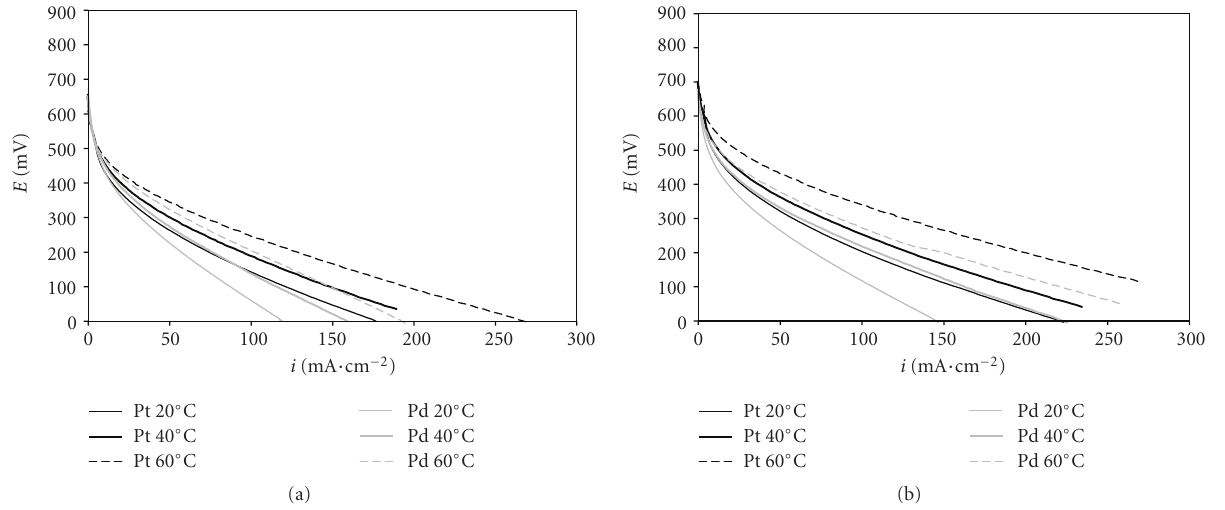
Figure 5: Comparison of polarization curves of a direct methanol fuel cell operating with air and 5M methanol with Pd/C and commercial Pt/C from E-tek as cathode catalyst at 20, 40, and 60 ◦